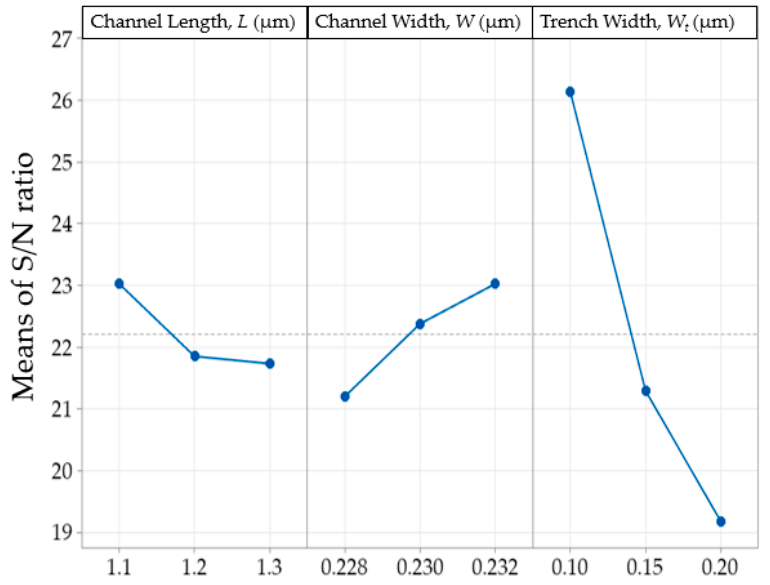
Figure 6. Plot of main effects of S/N ratio for V .